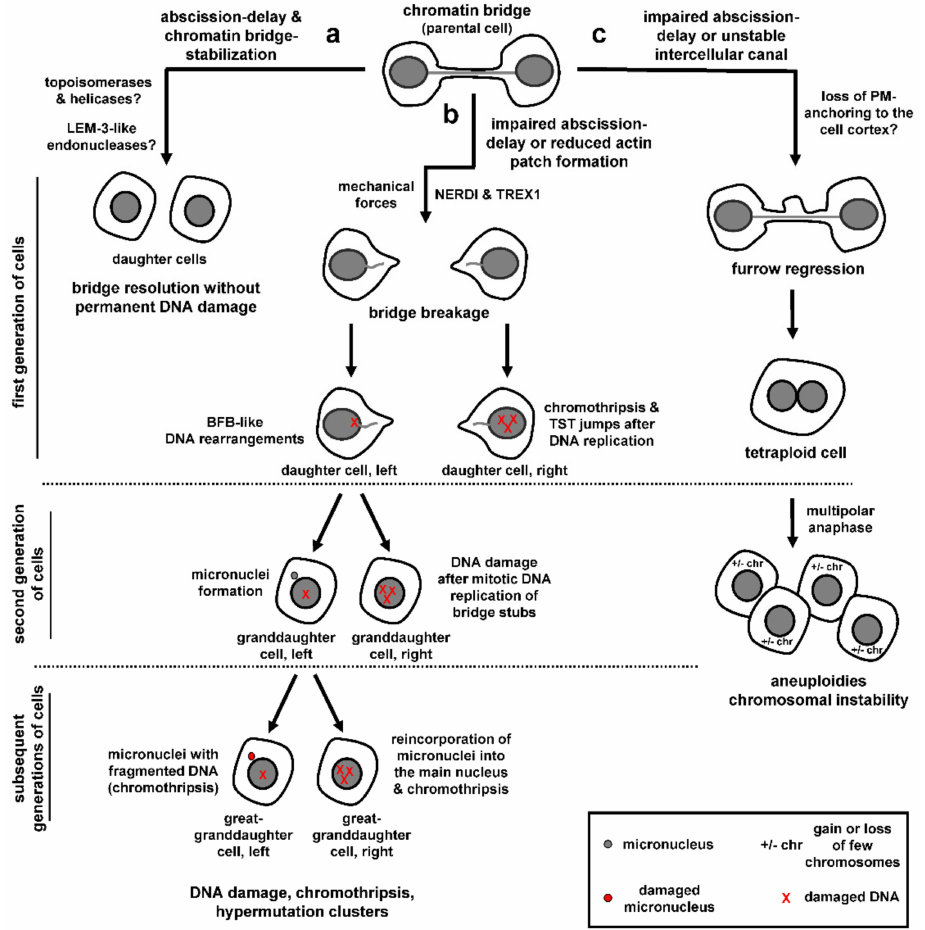
Figure 4. Potential outcomes of cytokinesis with chromatin bridges. ( a ) In abscission checkpoint-proficient cells with stable DNA bridges, chromatin bridges can be resolved without permanent DNA damage. ( b ) Impaired abscission- delay or reduced actin patch formation can cause chromatin bridge breakage, leading to accumulation of DNA damage, chromothripsis and generation of hypermutations clusters. ( c ) Unsuccessful resolution of chromatin bridges can lead to cleavage furrow regression, generation of tetraploid cells and chromosomal instability. See text for details. NERDI, nuclear envelope rupture during interphase; BFB, break–fusion–break; TST, Tandem Short Template; PM, plasma membrane; chr,